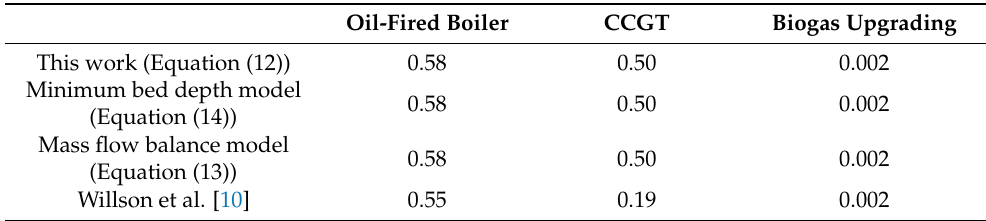
Table 9. Comparison of volumetric bed flow rates (m 3 /s) calculated by different energy balance models.